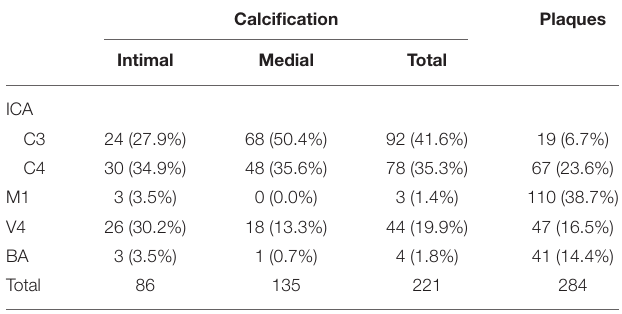
TABLE 2 | Distributions of calcification assessed on CT and atherosclerotic plaques assessed on VWMRI in the segments of large intracranial arteries. Calcification